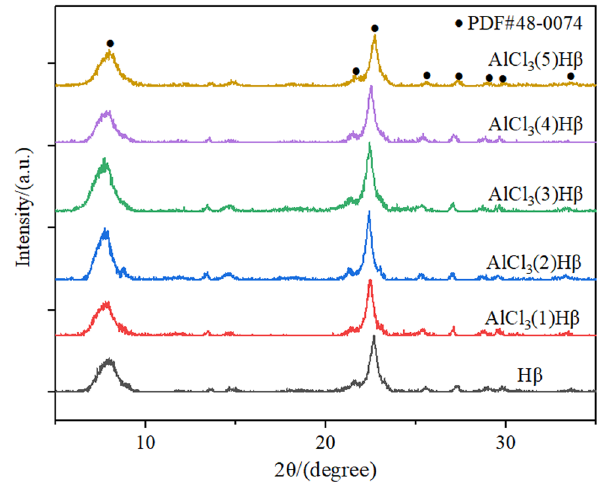
Figure 1: XRD patterns of AlCl 3 /H β catalysts prepared with di ff erent concentrations of AlCl 3